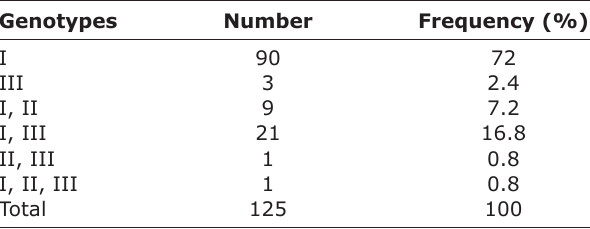
Table-2: Overall frequency of different genotypes based on both SAG2 and GRA6 gene RFLP-genotyping.